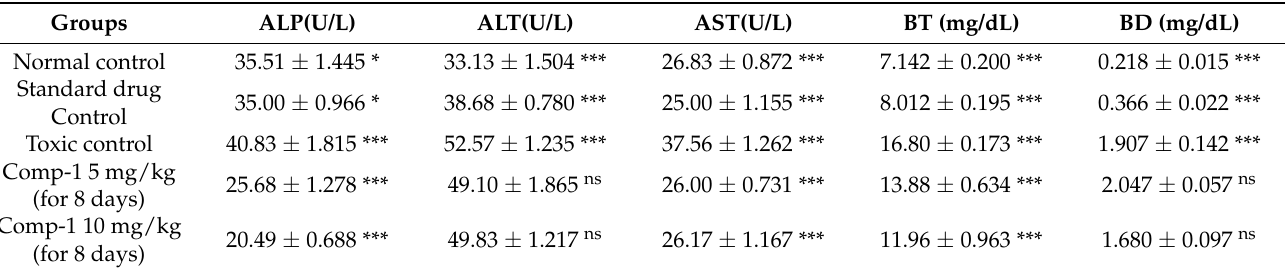
Table 2. Hepatoprotective effects of Comp-1 in 5-FU-induced toxicity in